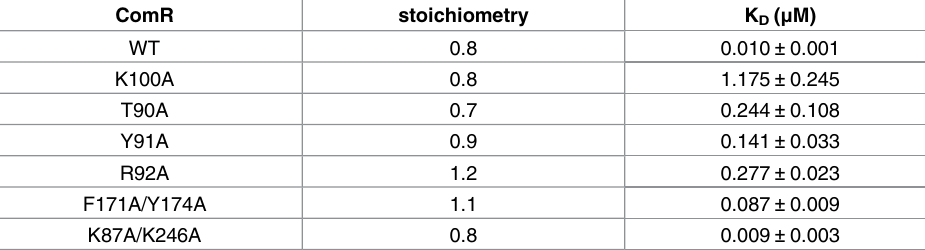
Table 1. XIP binding on ComR WT and ComR mutant proteins as measuredby